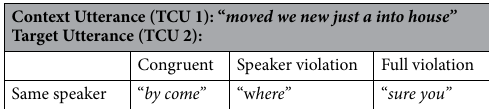
Table 6. Example stimulus from Experiment 2 in the congruent, speaker violation, and full violation conditions.